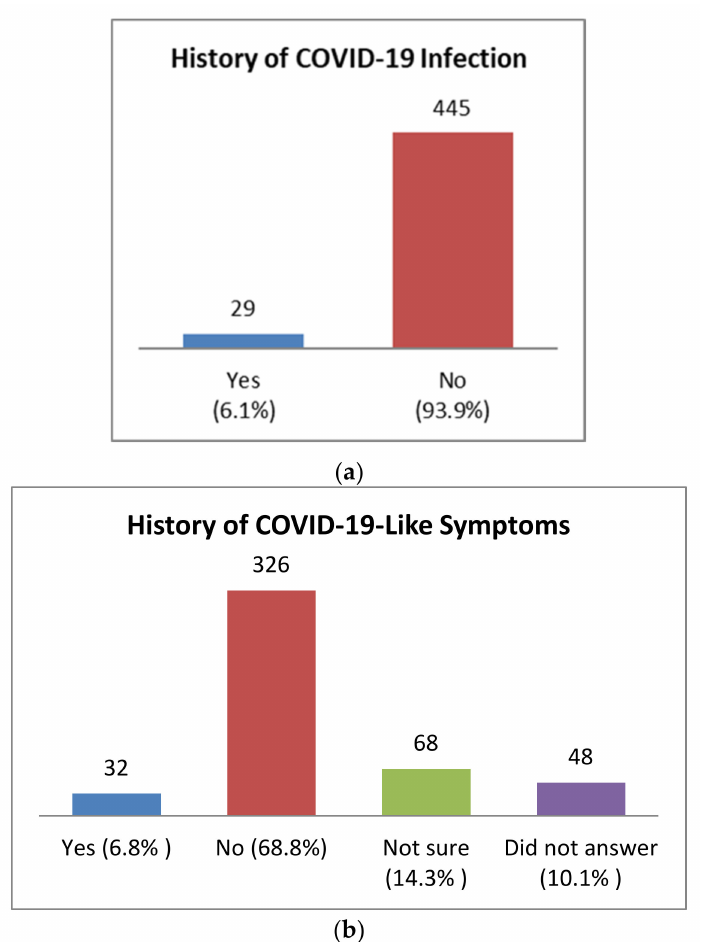
Figure 2. Study participant’s history of COVID-19 encounters. ( a ) Prior history of COVID-19 infection. Only cases that were confirmed with reverse transcriptase-polymerase chain reaction (RT-PCR) tests were included. ( b ) Presence of COVID-19 like symptoms before vaccination; these are cases where the study participant had one or more COVID-19-like symptoms but did not perform any confirmatory RT-PCR